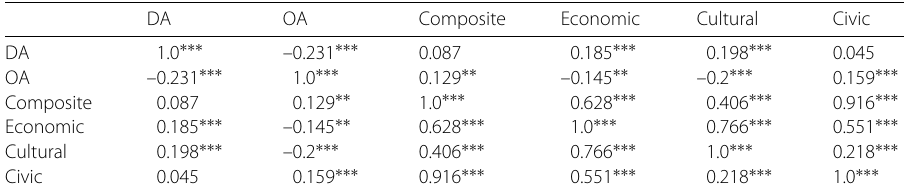
Table 2 Spearman correlation table for immigrants in the United States: Vigdor’s assimilation scores and DA & OA indices ( n = 292) DA OA Composite Economic Cultural Civic DA 1.0 ∗∗∗ –0.231 ∗∗∗ 0.087 0.185 ∗∗∗ 0.198 ∗∗∗ 0.045 OA –0.231 ∗∗∗ 1.0 ∗∗∗ 0.129 ∗∗ –0.145 ∗∗ –0.2 ∗∗∗ 0.159 ∗∗∗ Composite 0.087 0.129 ∗∗ 1.0 ∗∗∗ 0.628 ∗∗∗ 0.406 ∗∗∗ 0.916 ∗∗∗ Economic 0.185 ∗∗∗ –0.145 ∗∗ 0.628 ∗∗∗ 1.0 ∗∗∗ 0.766 ∗∗∗ 0.551 ∗∗∗ Cultural 0.198 ∗∗∗ –0.2 ∗∗∗ 0.406 ∗∗∗ 0.766 ∗∗∗ 1.0 ∗∗∗ 0.218 ∗∗∗ Civic 0.045 0.159 ∗∗∗ 0.916 ∗∗∗ 0.551 ∗∗∗ 0.218 ∗∗∗ 1.0